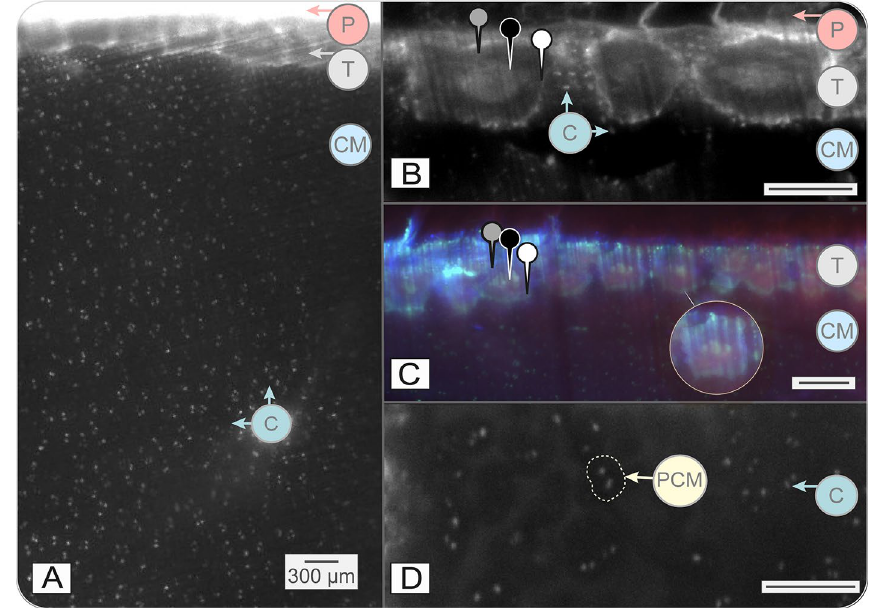
Fig. 8 AF images of tessellated cartilage using SPIM. A 2D AF image of an excised piece of tessellated cartilage, illustrating the large uncalci- fied cartilage matrix component relative to the tesserae. B 2D AF image of several tesserae with intervening joint regions. The three distinct anatomical regions often observed in AF images of tesserae are distinguishable, with the center (black pushpin) and the outer border (white pushpin) presenting brighter signals than the periphery (grey pushpin). Chondrocytes can be appreciated organized in series within the joints. Black and white image settings: λ = 488 nm / λ = 520/50 nm. C AF image of multiple tesserae in series. The central region and outer ex em border share the same green fluorescence (λ = 488 nm; λ = 520/50 nm), which differs from the red fluorescence signal of the peripheral ex em region (λ = 405 nm, λ = 482/25 nm), also appreciated in the zoomed tessera (circle). Regions throughout the tissue also show a vague ex em blue AF (λ = 561 nm, λ = 593LP), but this did not appear to be associated with specific structures. Chondrocytes in the unmineralized ex em cartilage matrix presented AF with λ = 488 nm and λ = 520/50 nm. D AF image of the unmineralized cartilage matrix. Groups of chondro- ex em cytes can be observed surrounded by a pericellular matrix (PCM), darker than the interstitial extracellular matrix intervening between chon- drocyte groups. All scale bars = 300 µm. Chondrocytes (C), Unmineralized cartilage matrix (CM), Pericellular matrix (PCM), Perichondrium (P), Tesserae